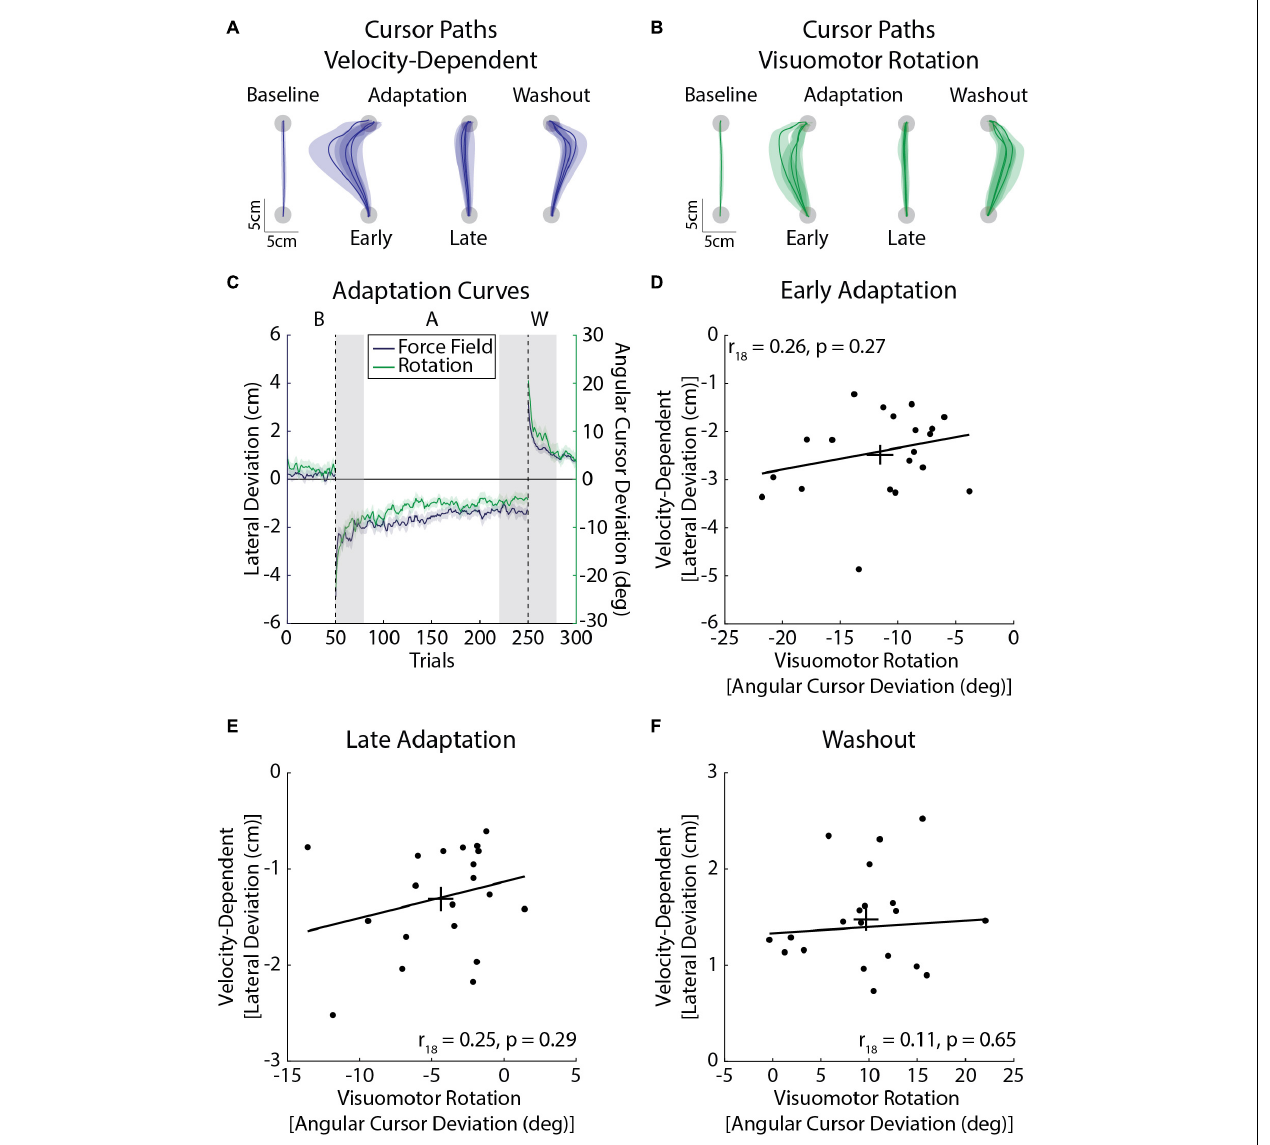
FIGURE 7 | Average adaptation for the velocity-dependent force-field (blue) and visuomotor rotation (green) task ( Experiment 2b ; n = 20, 10 female). (A) Average cursor paths from the velocity-dependent force field. Cursor paths were averaged across the baseline phase. The first and last three trials of the adaptation phase were averaged across participants. Similarly the first three trials of the washout phase were averaged across participants. Note that cursor and hand paths were the same in the velocity-dependent force field. (B) Average cursor paths from the visuomotor rotation. Cursor paths are presented in the same manner as panel (A) . (C) Peak lateral and angular cursor deviations throughout the experiment. The line represents the group mean and the shaded regions represent the SEM. Individual differences in adaptation were measured in Early Adaptation , Late Adaptation , and Washout (shaded gray regions). The left y -axis corresponds to the velocity-dependent force-field task (peak lateral deviations) and the right y -axis to the visuomotor rotation task (cursor angle). (D) Amount of adaptation in Early Adaptation in the force field and rotation tasks. The angular deviations of the cursor in the visuomotor rotation task are plotted on the x -axis and peak lateral deviations for the velocity-dependent force task are plotted on the y -axis. The trendline was obtained via robust linear regression and is used for visualization purposes. Error bars represent the mean and SEM. (E) Average amount of adaptation in Late Adaptation. (F) Average peak lateral and angular cursor deviations in Washout. Data in panels (E,F) are presented in the same format as panel (D)